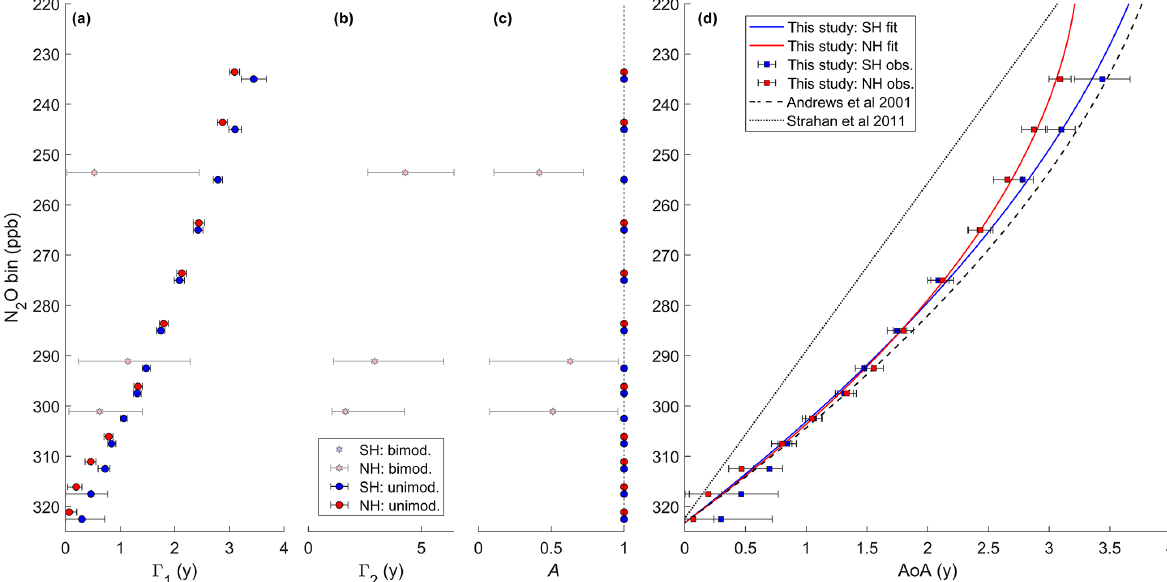
Figure 3. Hemisphere-specific properties of the age spectra in different N 2 O bins from the 10s averaged airborne observations estimated by Markov chain Monte Carlo. Panels (a) – (c) show the value and 95% confidence interval of (cid:48) 1 (cid:48) 2 and A in each bin for either a unimodal (blue and red circles) or bimodal (faint blue and faint red stars) age spectrum depending on which type was preferentially selected by the algorithm. N 2 O values are offset by 1.4ppb for all Northern Hemisphere estimates (NH, red) for visual clarity in panels (a) – (c) . Panel (d) shows the mean AoA and confidence interval of the age spectra ensemble in each bin (i.e., unimodal and bimodal together). These data are fit by a quadratic polynomial for each hemisphere with a fixed y intercept (NH AoA = − 0 . 0002381 ( 323 . 23 − N 2 O ) 2 + 0 . 05567 ( 323 . 23 − N 2 O ) ; SH AoA = − 0 . 0001723 ( 323 . 23 − N 2 O ) 2 + 0 . 05317 ( 323 . 23 − N 2 O ) ). Previous relationships published by Andrews et al. (2001) and Strahan et al. (2011) are given as a dashed and dotted line for reference. y -intercept values of the previously published N 2 O–AoA calibrations have been updated to reflect the gradual increase in tropospheric N 2 O between 1997 and the new reference year 2009.